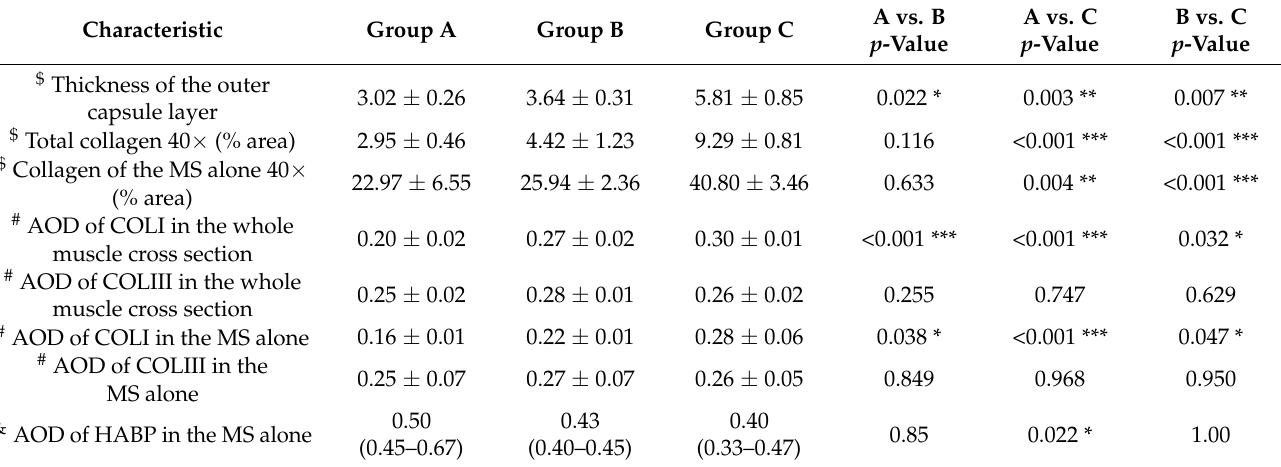
Table 1. Collagen constituting the ECM of the MSs in the mouse skeletal